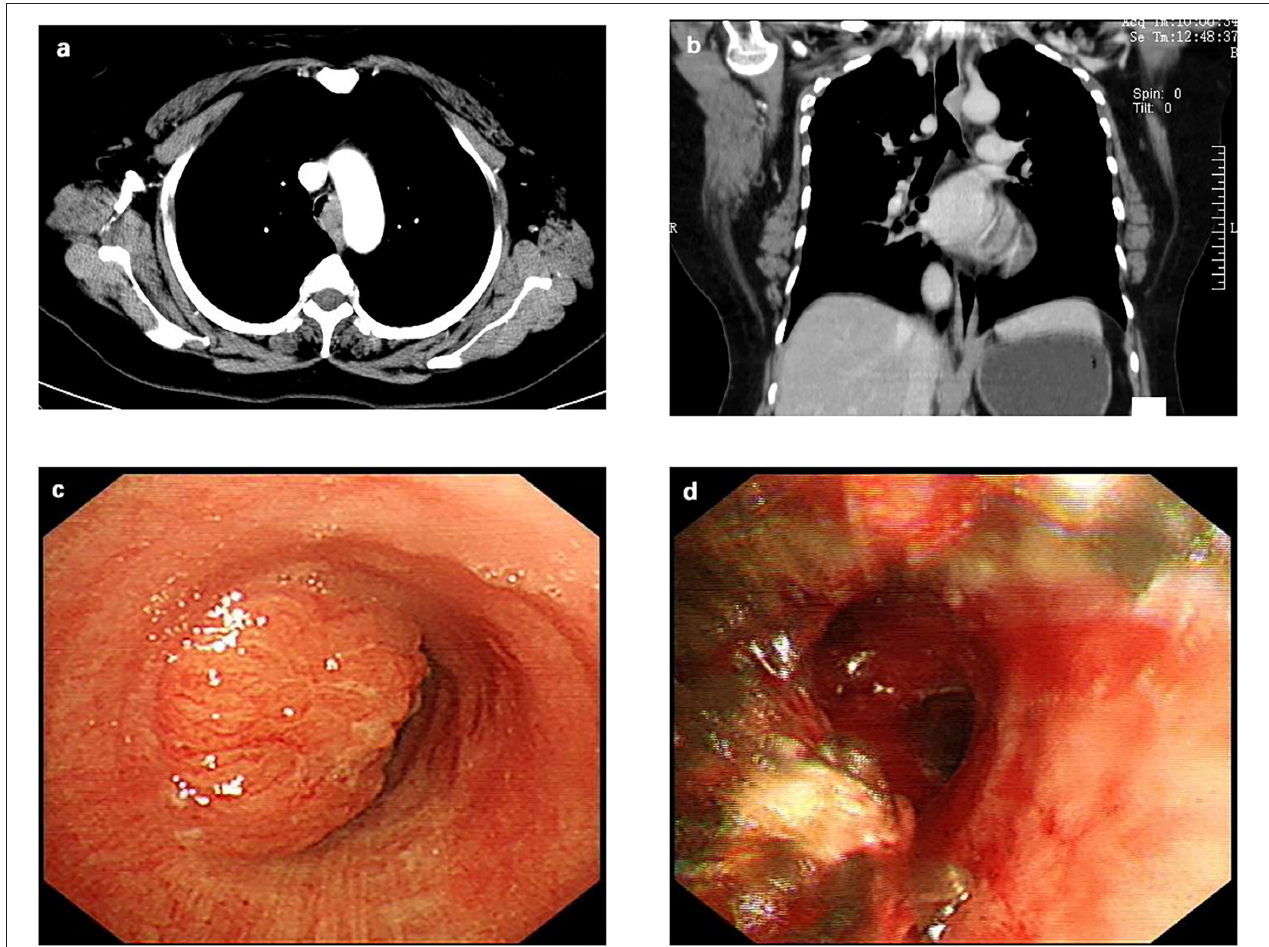
FIGURE 1 | Preoperative examination of the patient. (a) The contrast-enhanced chest computed tomographic scan revealed a tracheal mass occupying a size of ∼ 14mm × 23mm located at the T2 and T3 vertebrae; (b) A coronal computed tomographic scan revealed the tracheal mass; (c) A bronchoscopy showed a protruding tumor in the middle and lower trachea with nearly total tracheal occlusion. (d) After a partial tumor was removed via bronchoscopy with argon knife and cryotherapy, the tracheal lumen is more obvious patency than